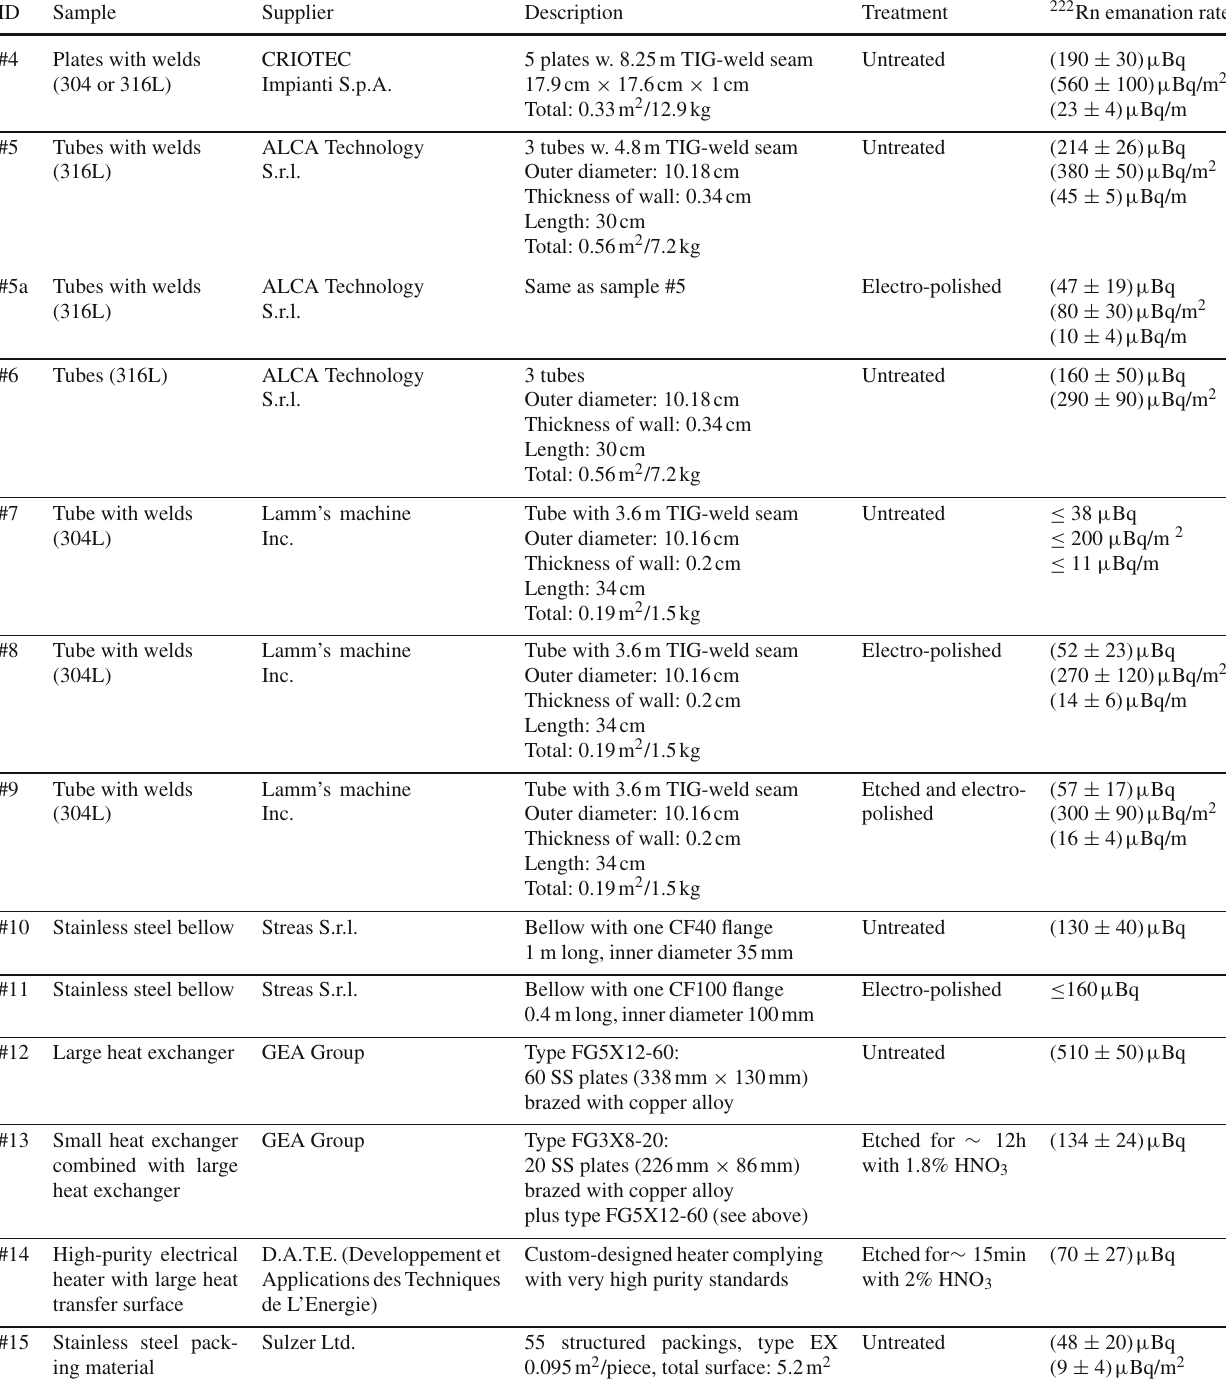
Table 2 222 Rn emanation results of various stainless steel (SS) samples. Where relevant, the normalization to surface area and to weld seam